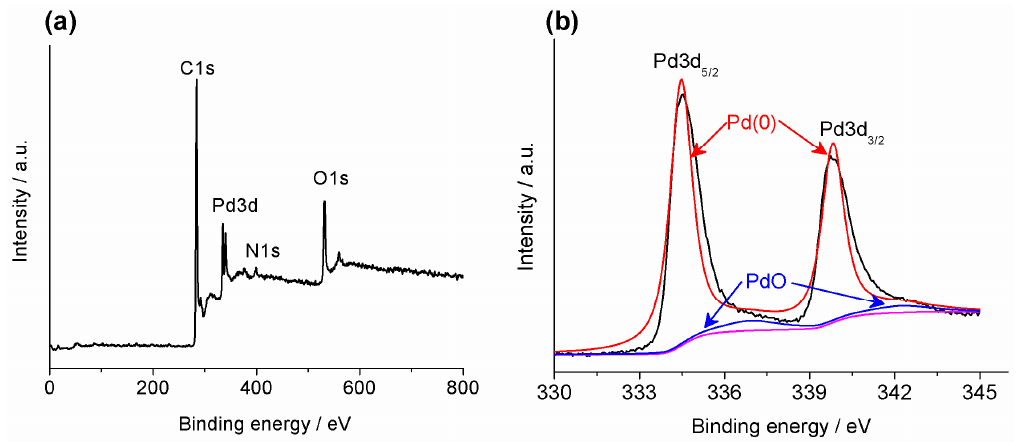
Figure 4. ( a ) Survey XPS (X ‐ ray photoelectron spectroscopy) spectra of Pd/PP ‐ 3; ( b ) Deconvoluted